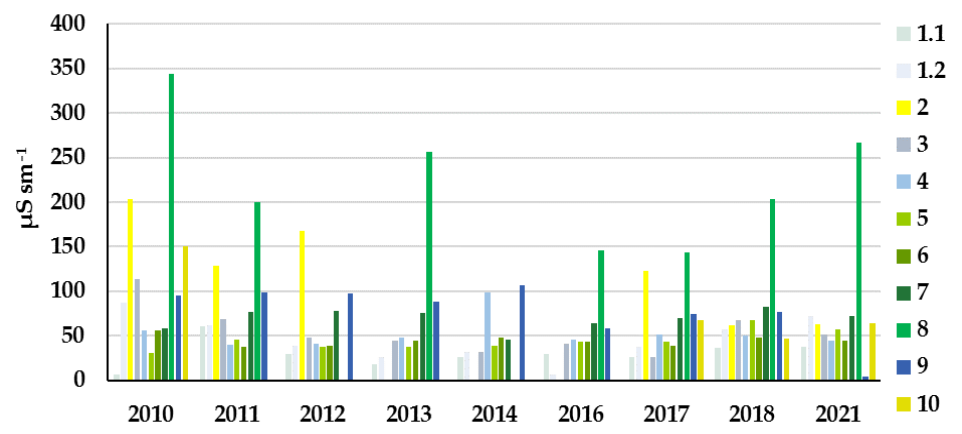
Figure 8. Water electrical conductivity in wells for GWL measurements during the growing season (May − August) for the observation period.